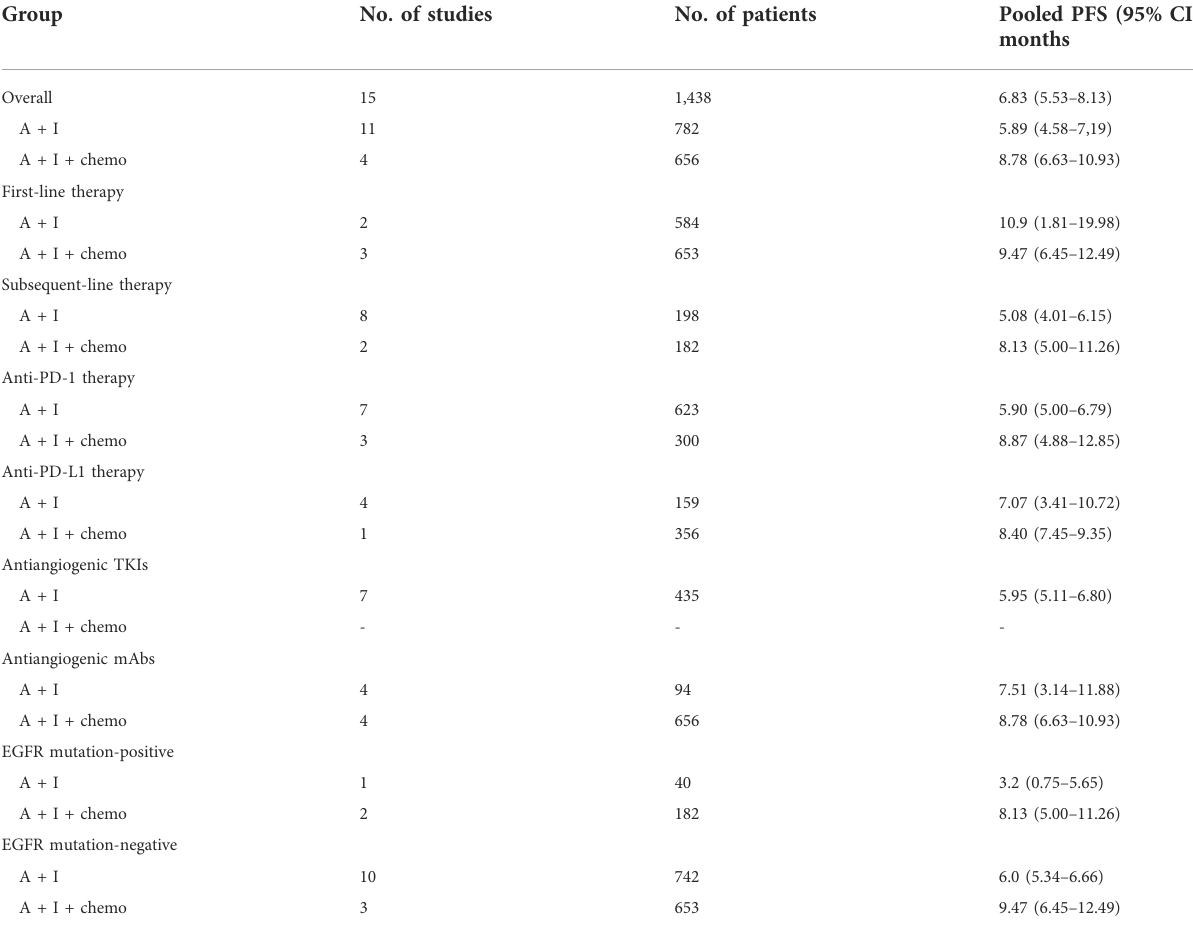
TABLE 3 Median progression-free survival (mPFS) for combined immunotherapy and antiangiogenesis therapy with or without chemotherapy.